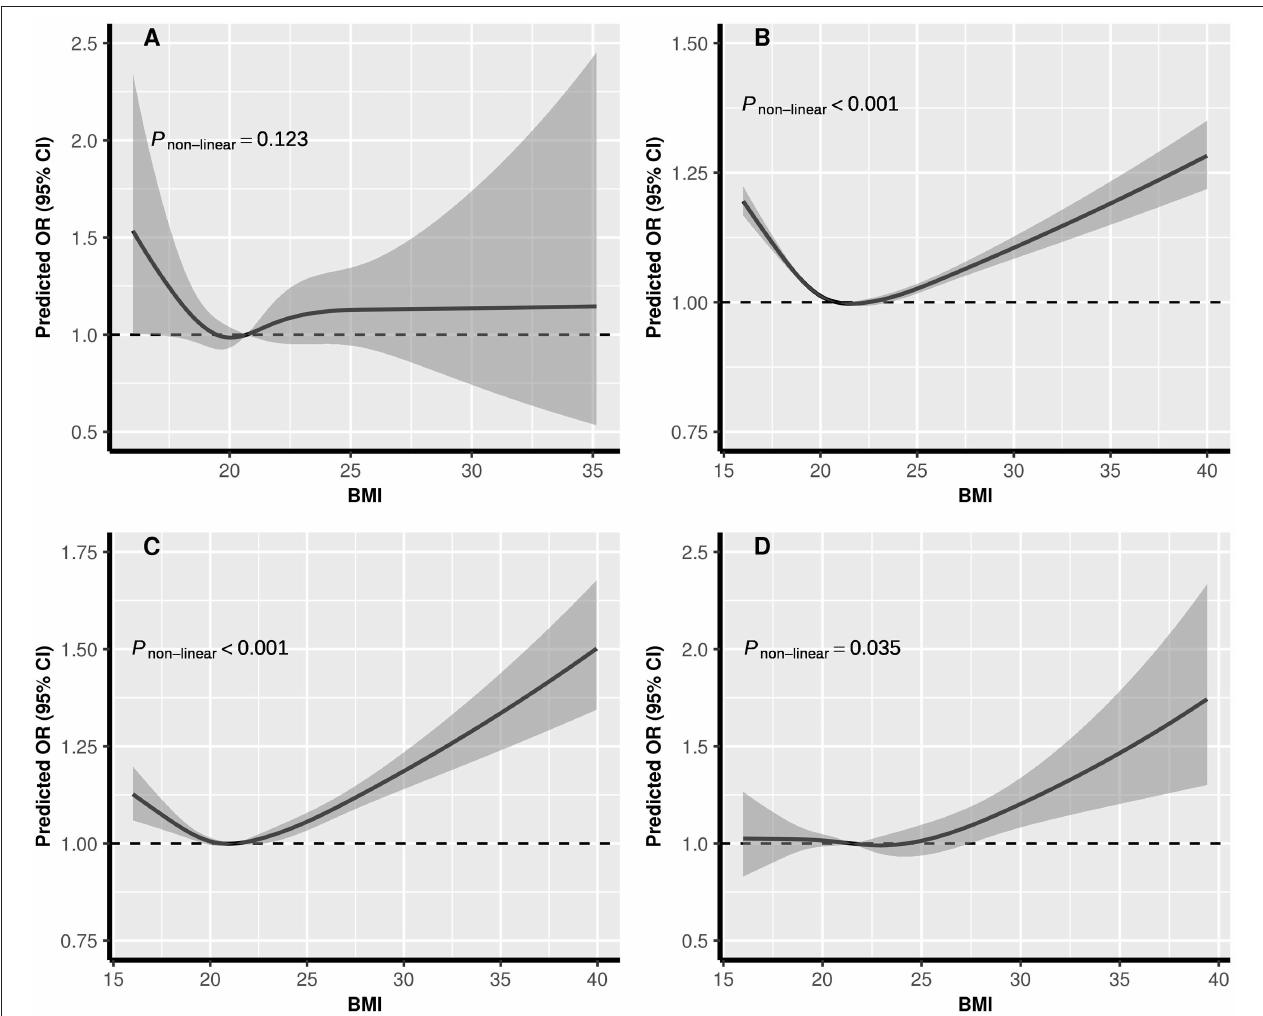
FIGURE 2 | The exposure-response relationship of pre-conception BMI with PTB, stratified by FPG. BMI, body mass index; FPG, fasting plasma glucose; PTB, (pre-term birth, 28 to < 37 weeks). (A) Hypoglycemia; (B) Normal glucose; (C) Pre-diabetes; (D) Diabetes. In the graph, black lines, and shaded gray areas represent predicted ORs and 95% CIs, respectively. The models were adjusted for characteristics of women (age, education, ethnic, occupation), parity, smoking and alcohol drinking before or during early pregnancy, history of adverse pregnancy outcomes, history of hypertension, thyroid dysfunction, anemia, infectious disease, and sex of